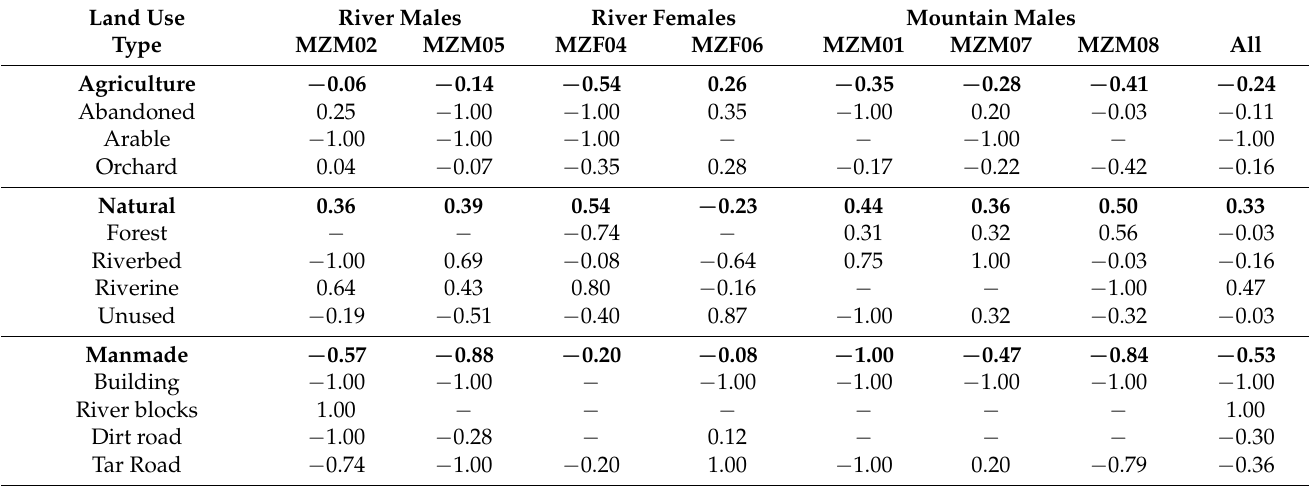
Table 2. Jacobs’ index for land use classes (in bold) and subclasses at leopard cat nighttime locations: land use types are selected (>0.2), avoided (< − 0.2), or used according to availability ( − 0.2–0.2), only land use types with a total sample size for nighttime locations and/or random points of >5 were